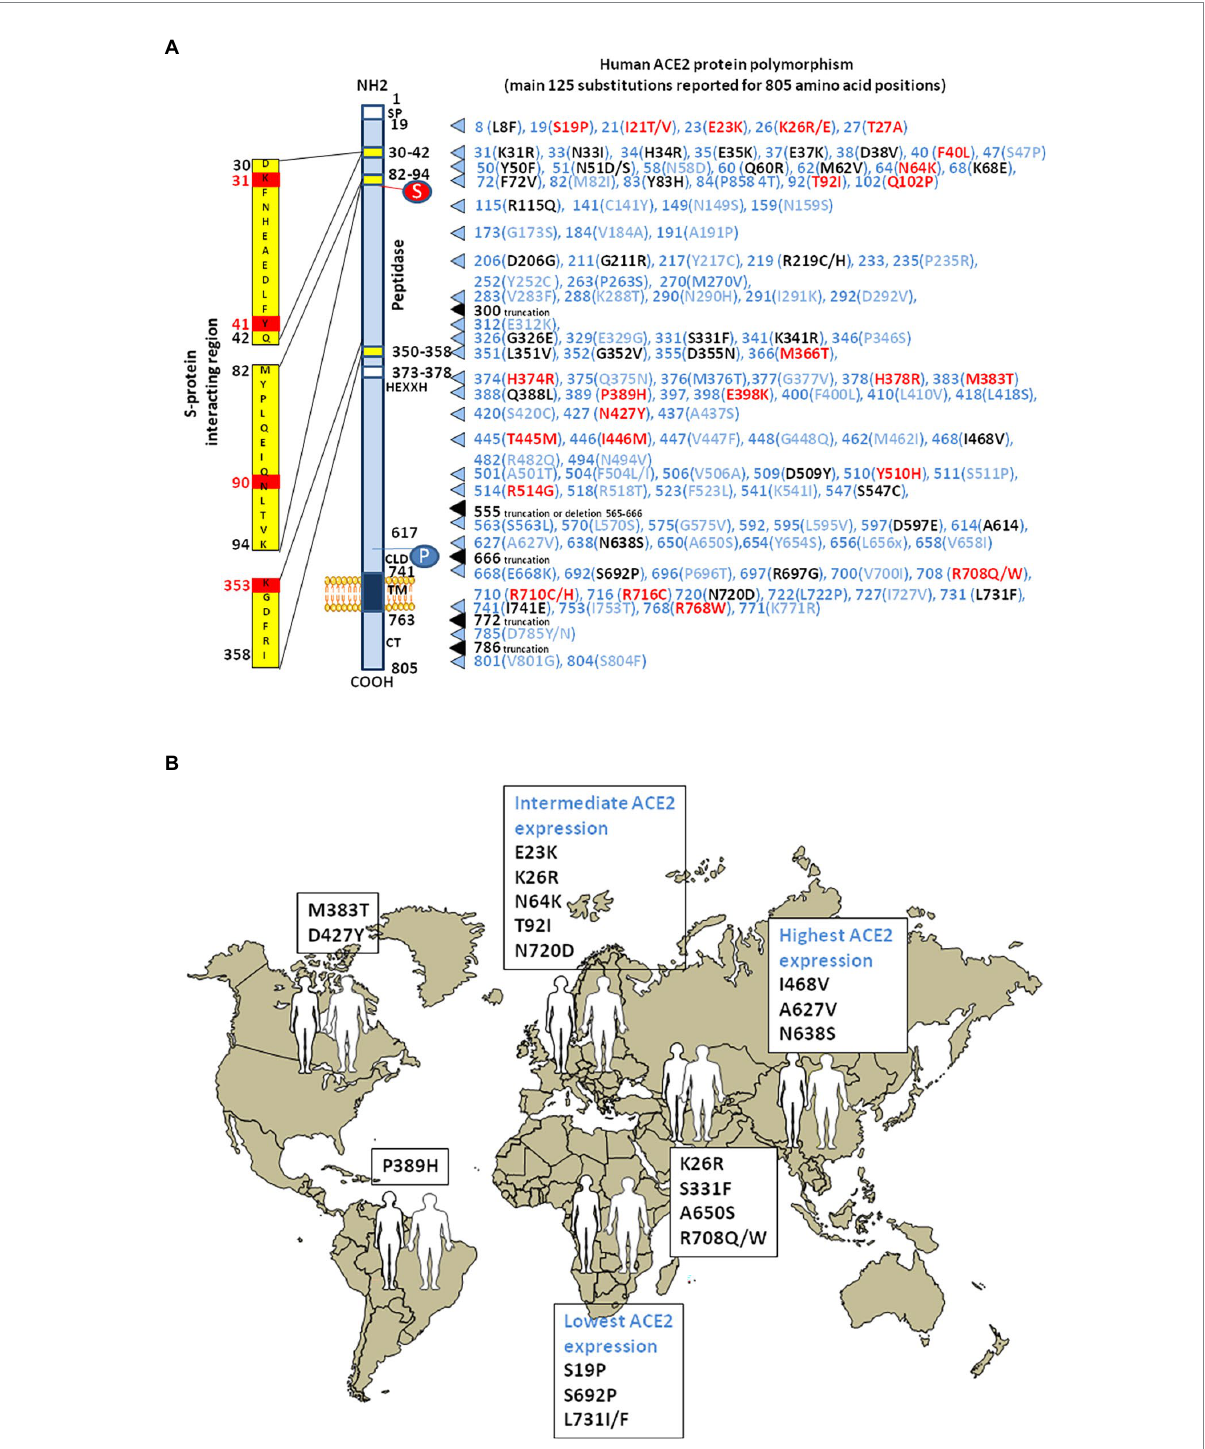
FIGURE 4 Human ACE2 polymorphism. (A) Schematic representation of the cell surface of the human ACE2 molecule and its major domains is drawn on left side of the figure. The amino acid positions are in black. Some of the amino acids considered to be important for viral tropism are marked in red. S, sugar; P, phosphorylation. The right part of the figure is a compilation of the main substitutions described in the literature. To simplify the figure, we used the single letter amino acids code instead of multiple letters code. The ACE2 substitutions in blue are considered neutral. The ACE2 substitutions in red are predicted to increase cell susceptibility to SARS-CoV-2. The ACE2 substitutions in black are predicted to decrease cell susceptibility to SARS-CoV-2. Polymorphisms in intronic regions might modify ACE2 regulation. Polymorphisms were able to induce a significant RNA secondary structure change. These alterations may lead to dysregulations in ACE2 transcription/translation or its protein stability. (B) The main geographical distribution of ACE2 protein polymorphisms in human populations. Representative substitutions in the human mACE2 per geographic